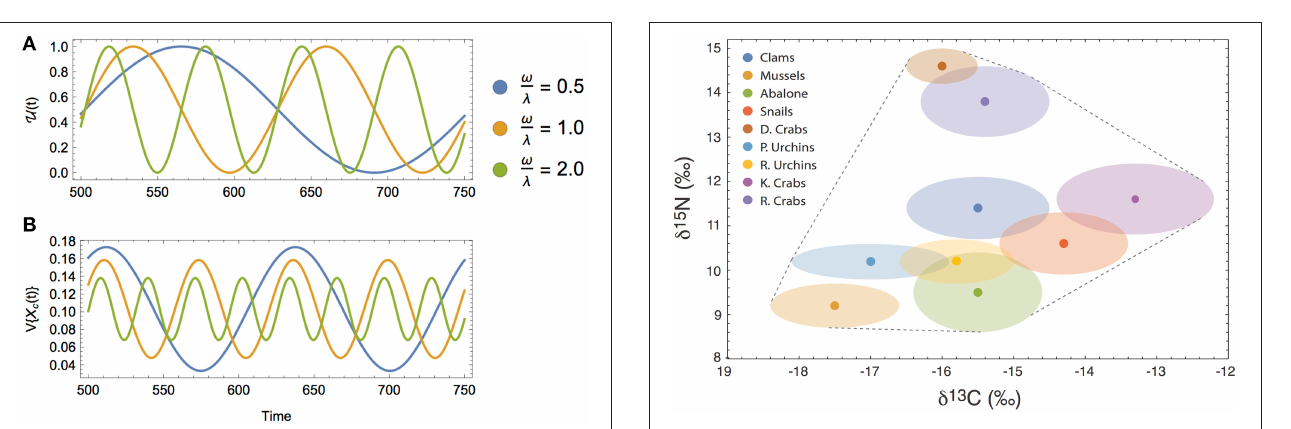
FIGURE 5 | (A) A sinusoidally varying diet, where U ( t ) increasing values of ω , or equivalently, decreasing timescales of dietary switching. (B) The isotopic variance of a consumer over time V increasing values of ω relative to the consumer’s incorporation rate λ . As the timescale of diet switching decreases relative to the timescale of isotopic incorporation, the amplitude of isotopic variance decreases due to increased isotopic averaging over faster shifts in diet.